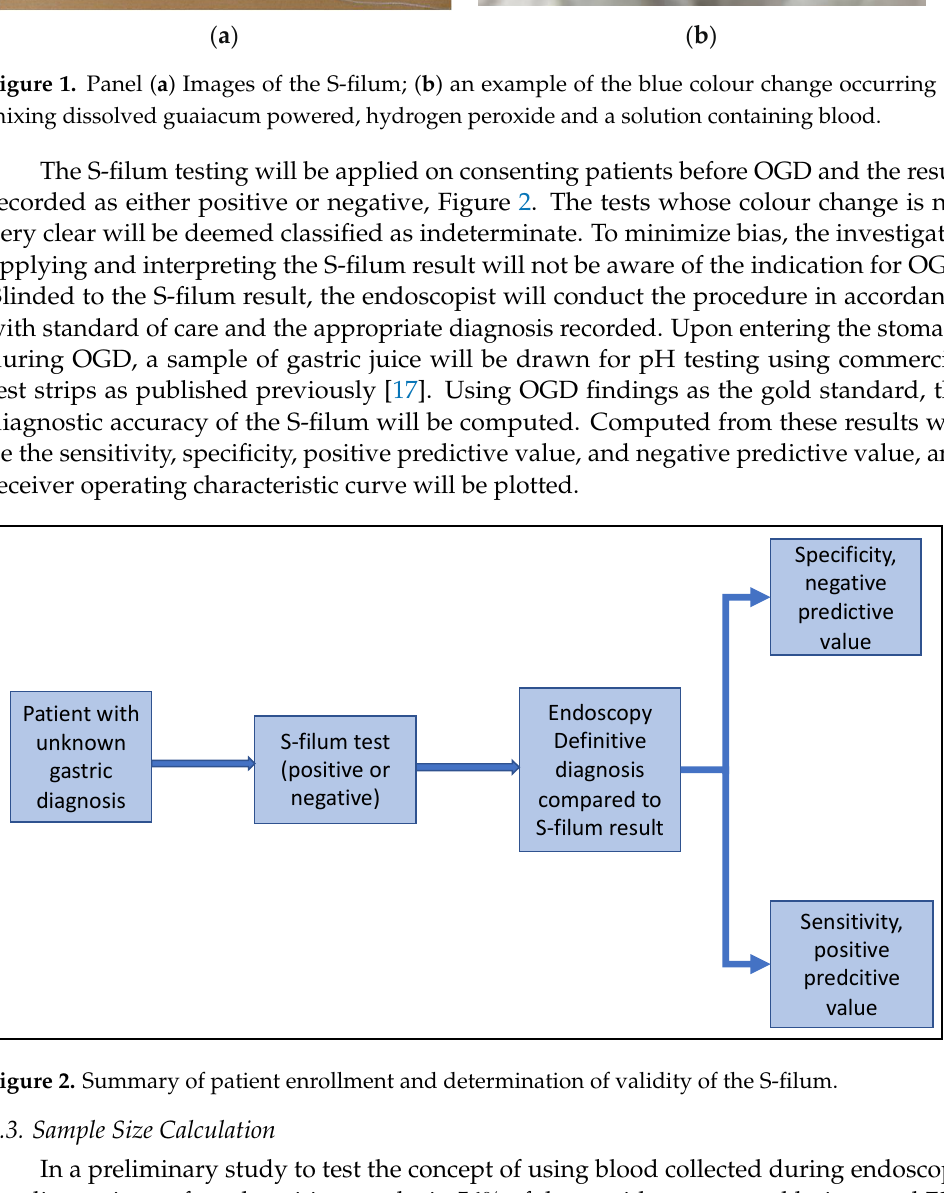
Figure 2. Summary of patient enrollment and determination of validity of the S-filum.